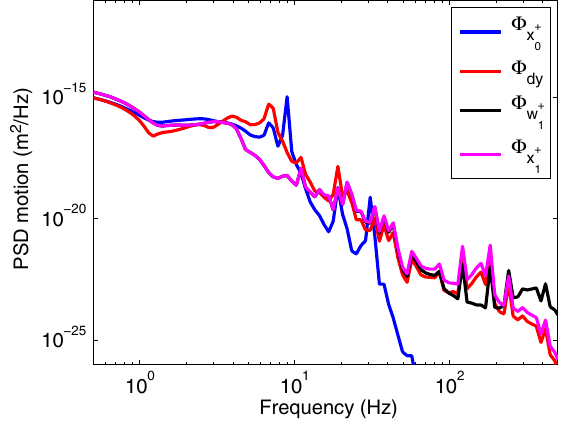
FIG. 6. Power spectral densities of the seismic response, without technical